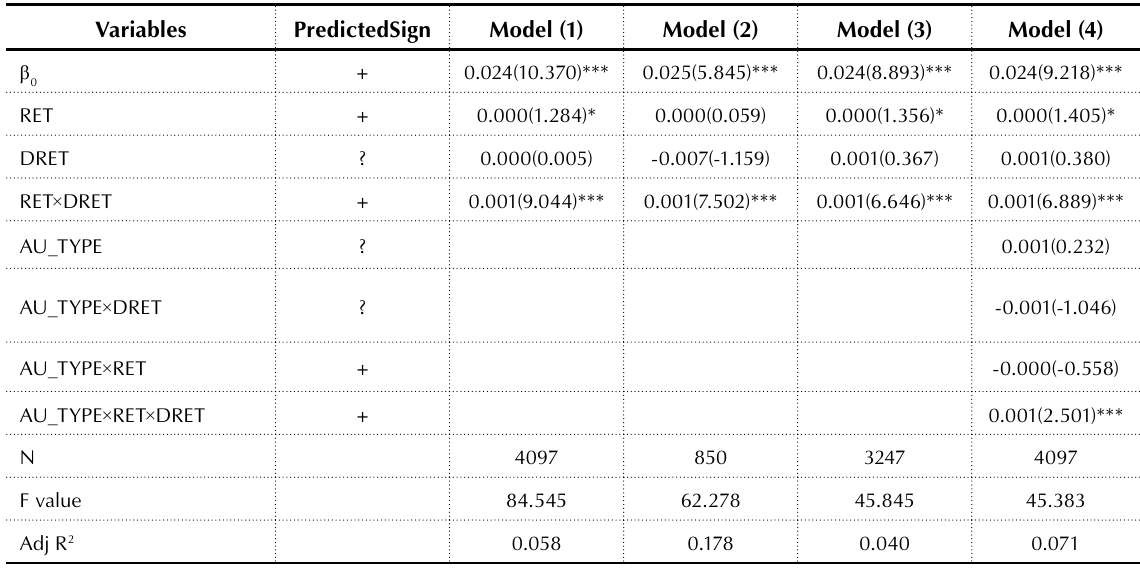
Table 4. Earnings conservatism and organization type: Earnings return